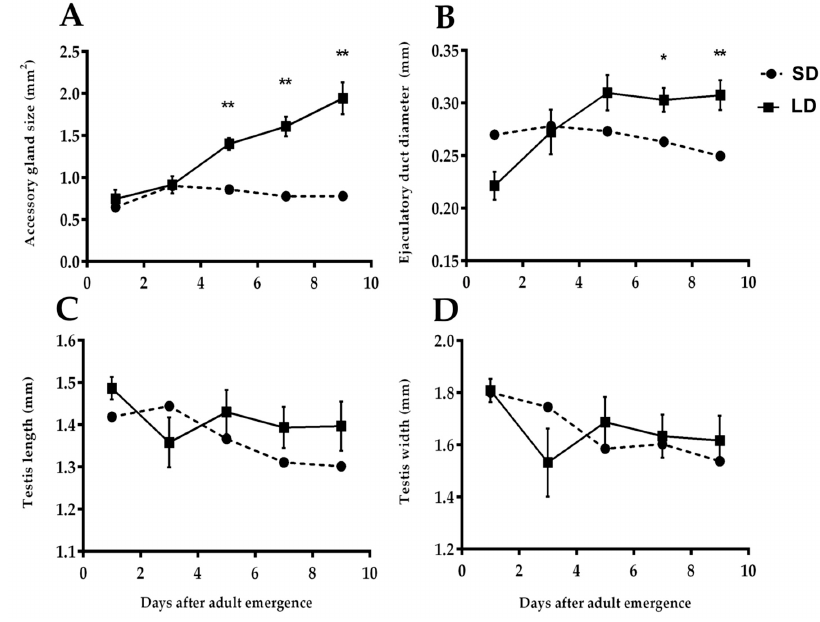
Figure 4. Difference in the development of different reproductive parts in prediapause ( SD ) and prereproductive ( LD ) males of R. pedestris . The parallel lines of graphs indicate the experimental days after adult emergence, whereas perpendicular lines show the development of accessory gland ( A ), ejaculatory duct ( B ), and testes of length ( C ) and width ( D ). Each point represents the mean ± SEM for 10 individuals. Asterisks indicate the significant differences between independent samples according to t -tests, * p < 0.05, ** p < 0.01.